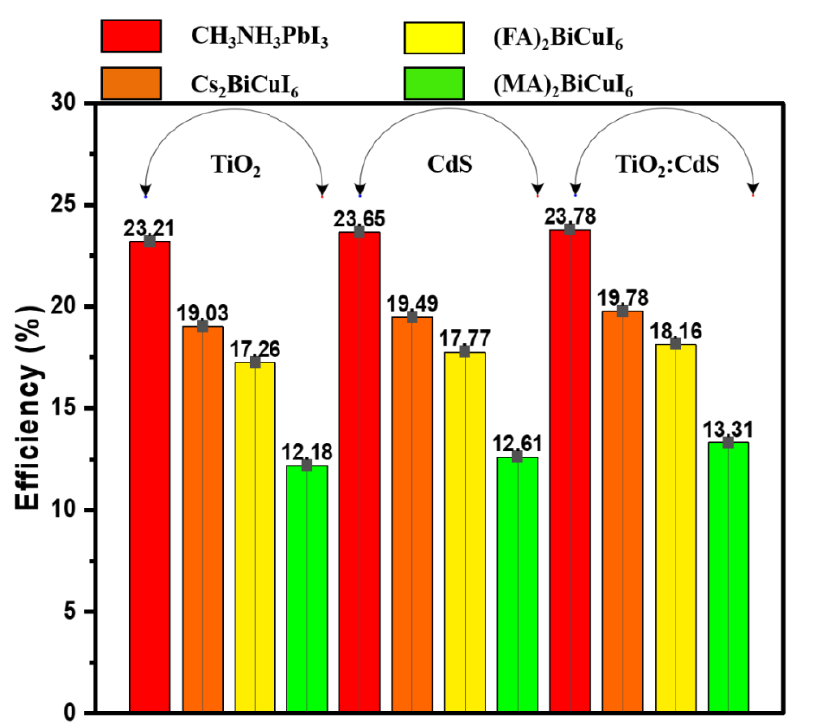
Figure 12. Power conversion efficiency comparison of different ETMs and perovskite materials.